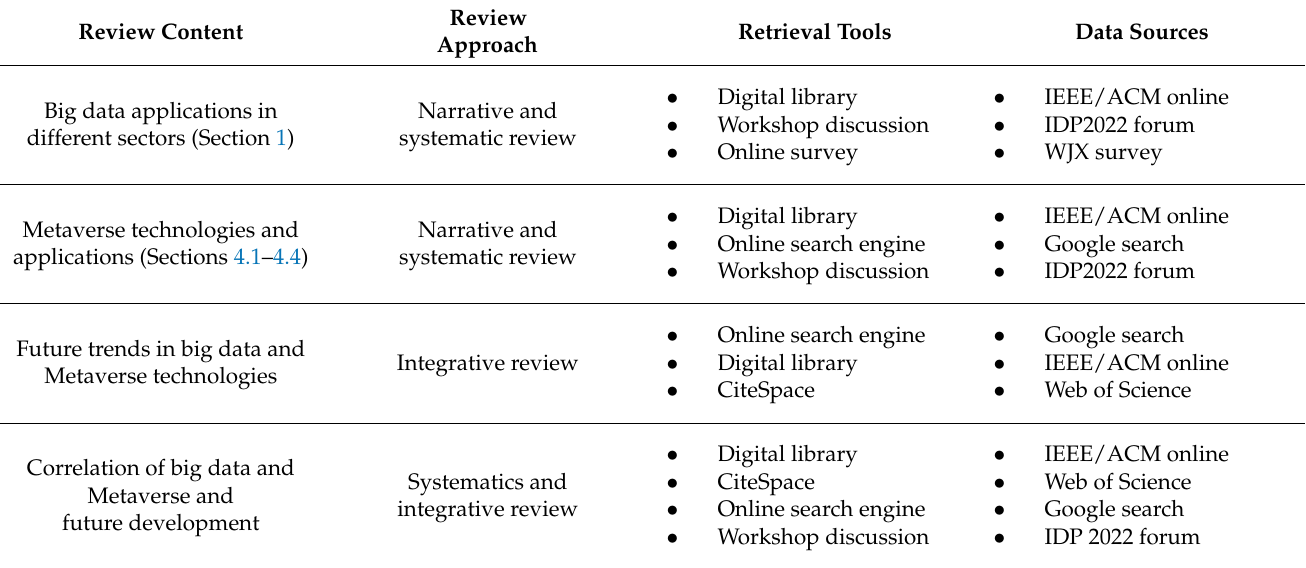
Table 4. Literature review methodologies.